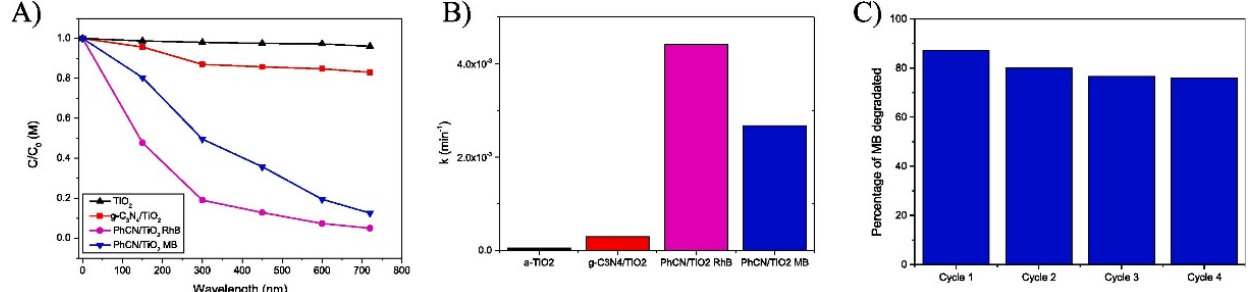
Figure 14. PhCN/TiO 2 photocatalyst and its application for the degradation of RhB and MB ( A ). Rate constant (k) by employing TiO 2 (anatase), g − C 3 N 4 /TiO 2 , and PhCN/TiO 2 as photocatalysts respectively ( B ). The stability of the catalyst is reported for the MB photodegradation ( C ) [166].